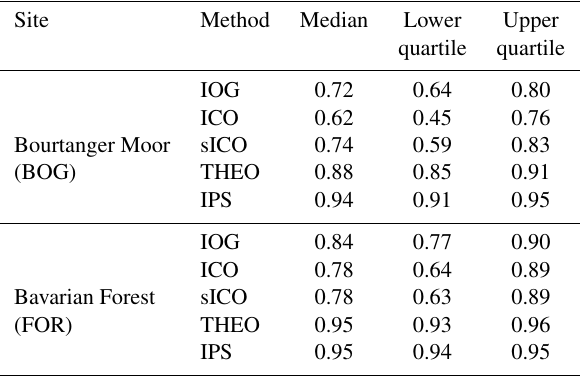
Table 3. Averages of monthly medians and lower and upper quar- tiles of α over the whole measurement period for all applied meth- ods at both